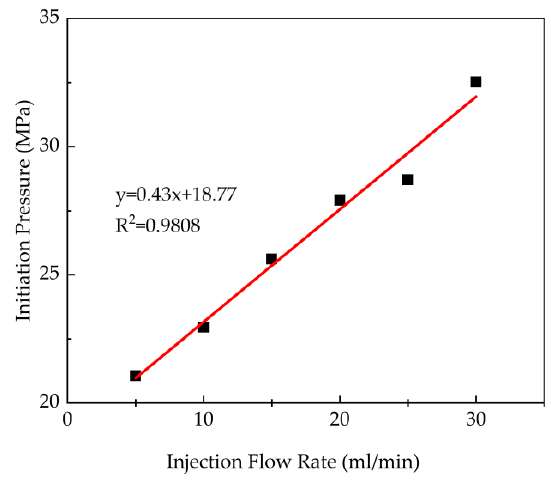
Figure 9. Influence of injection flow rate on the initiation pressure.